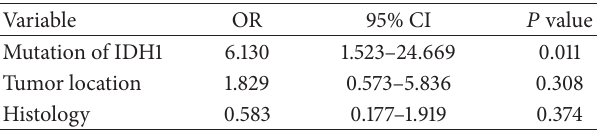
Table 2: Multivariate logistic regression